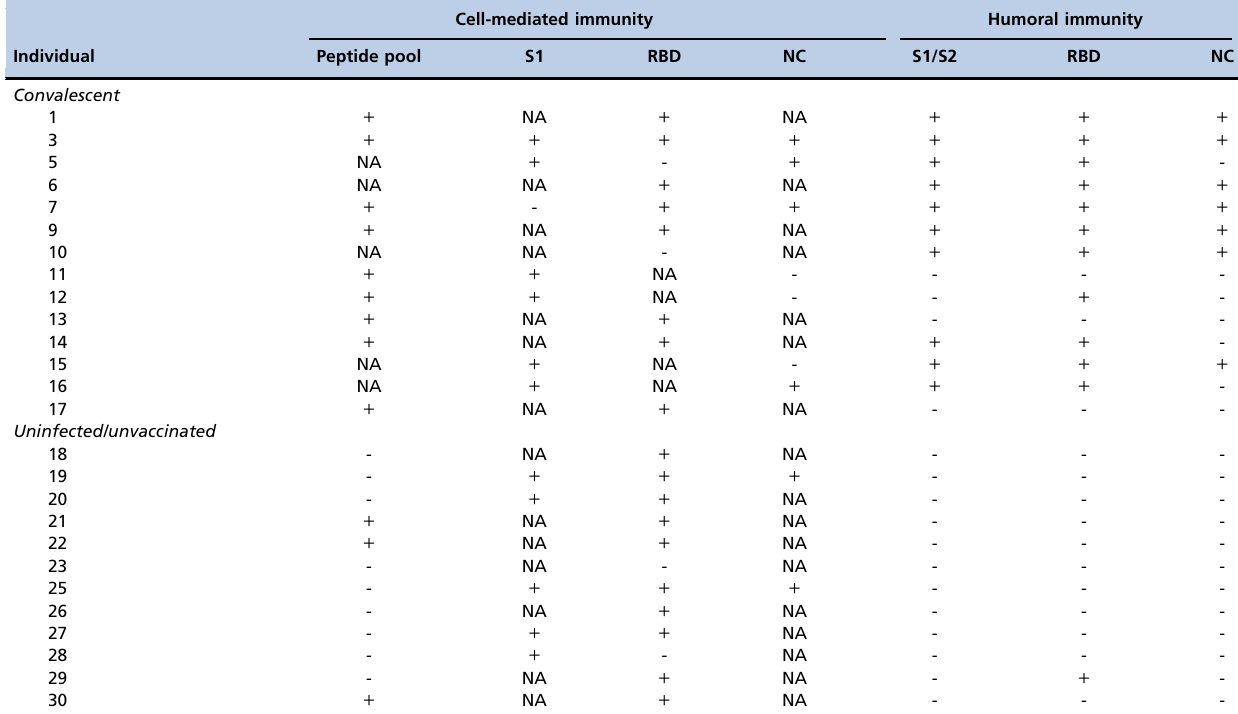
Table 2 - Humoral and cellular responses of COVID-19 convalescent individuals and uninfected/unvaccinated donors to SARS-CoV-2 antigens.